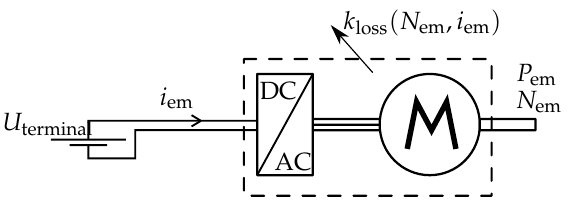
Figure 3. Terminology used to describe the electric motor. The dashed line represents the system’s boundary. U terminal is the voltage from a constant voltage power